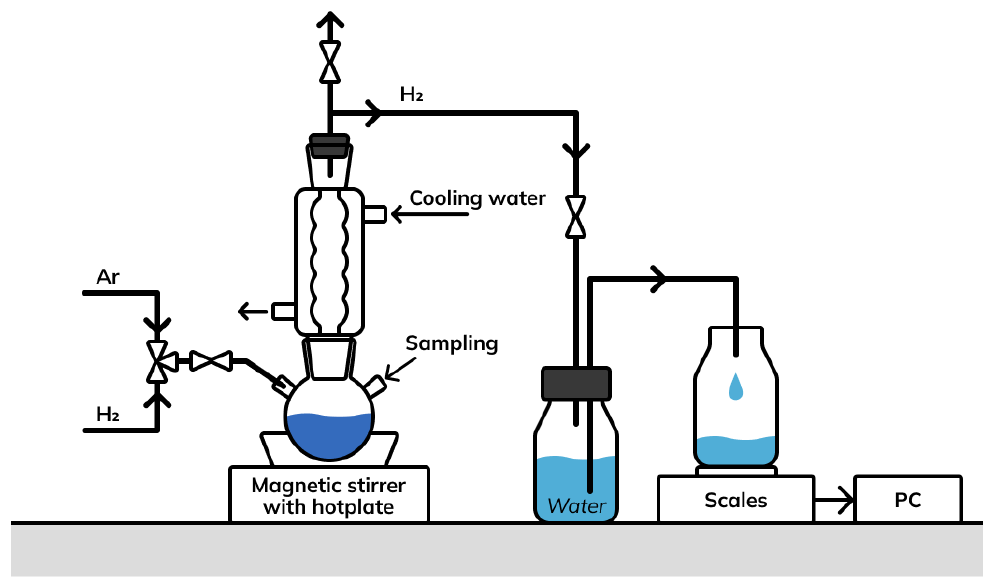
Figure 7. Schematic representation of dehydrogenation reactor.